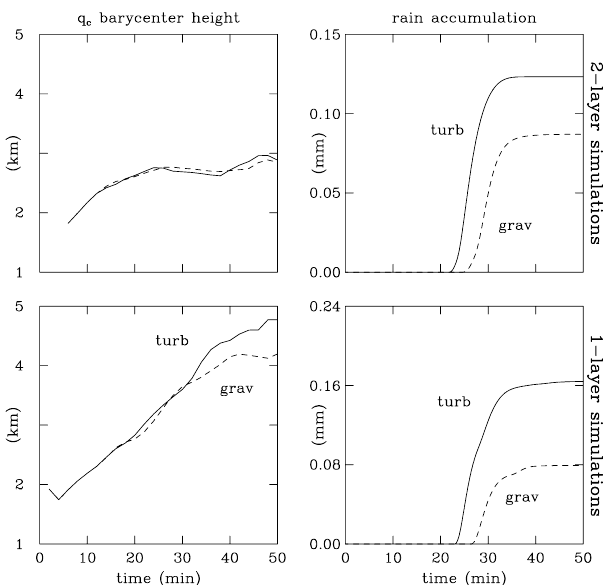
Fig. 5. The evolution of the height of the cloud water center of mass (left panels) and the mean (horizontally-averaged) surface rain ac- cumulation (right panels) for 2-D rising thermal simulations. Upper panels come from simulations where the thermal rise is arrested in the middle of the domain by the layer of increased stability. Lower panels show results from simulations where the thermal can rise un- obstructed towards the upper model